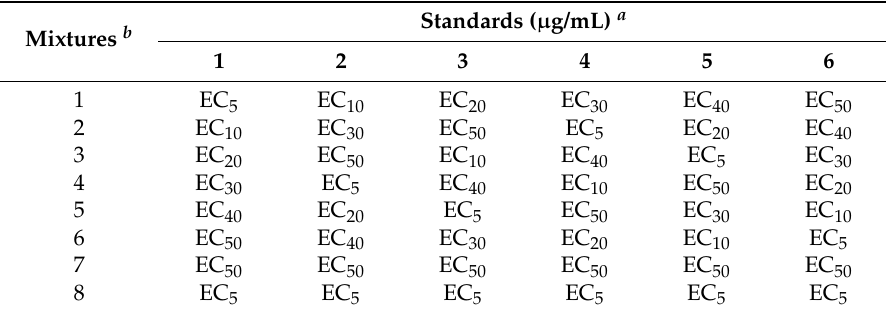
Table 3. Mixing ratio of six standards in each mixture.